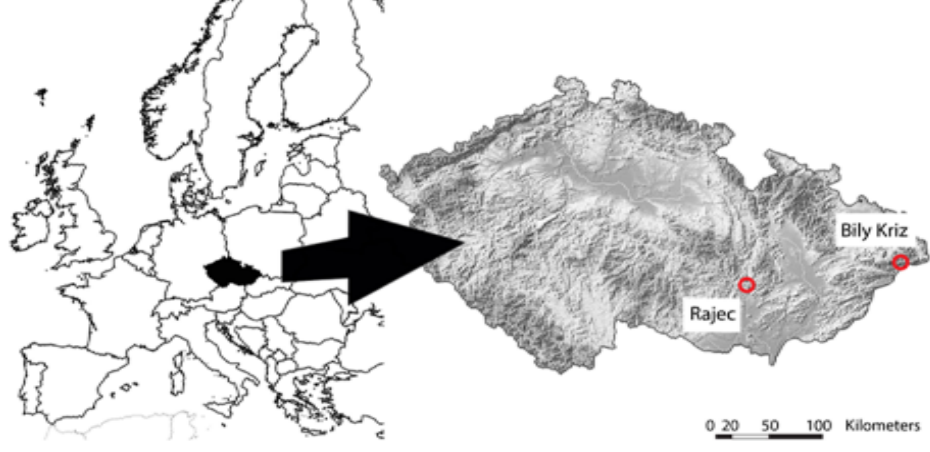
Figure 1. Geographical location of the two experimental study plots in the Czech